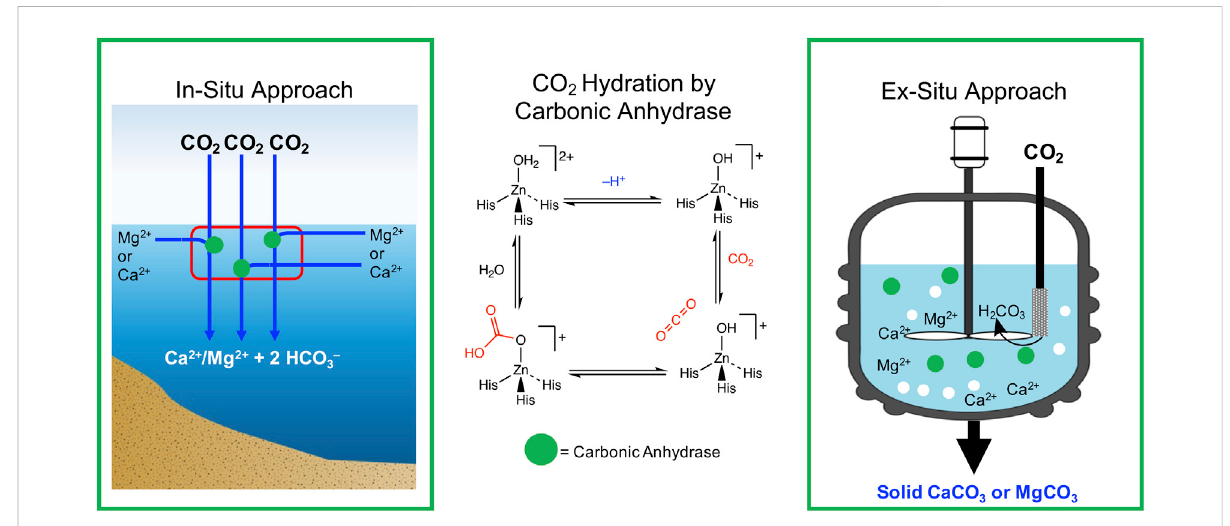
FIGURE 3 Illustration of how carbonic anhydrase can be used to increase alkalinity in both an in-situ and ex-situ approach. The middle panel of the fi gure describes the proposed mechanism for CO 2 hydration (His =